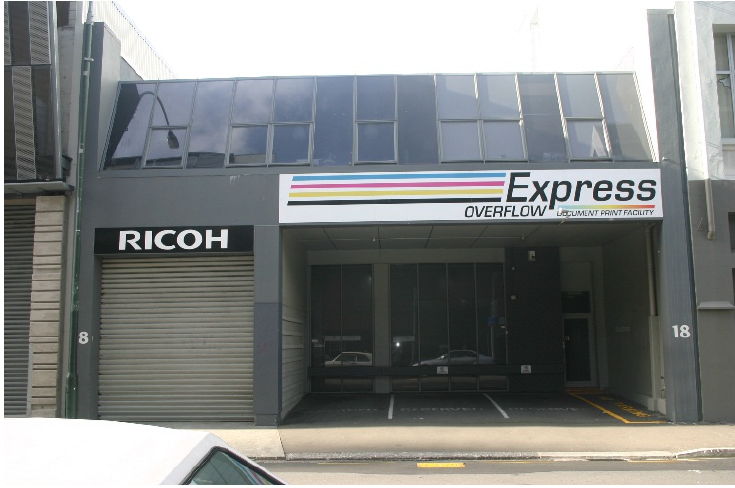
Figure 3. The least liked building in College Street was also judged by survey participants to form a positive relationship with the building to the